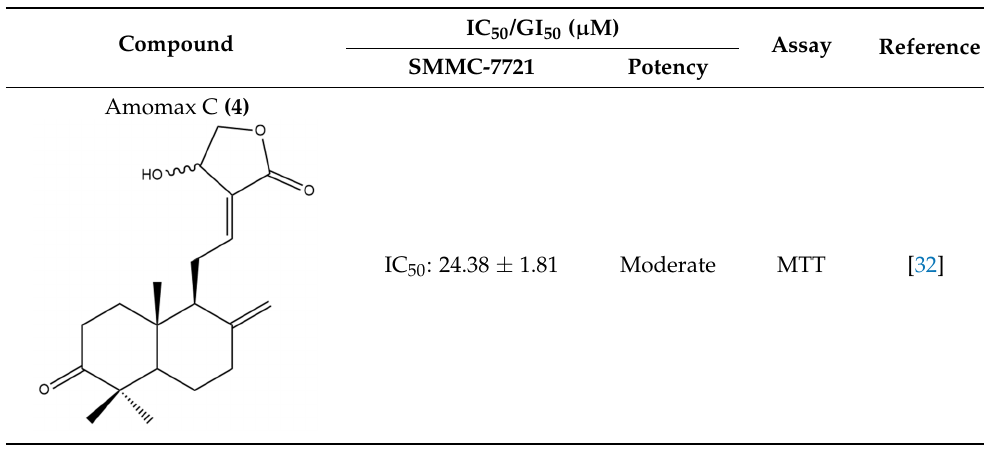
Table 8. Cytotoxic activities of labdane-type diterpenes from the Zingiberaceae against SMMC-7721 cervical cancer cell line.